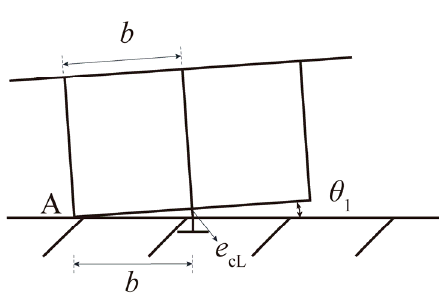
Figure 5. The additional elongation